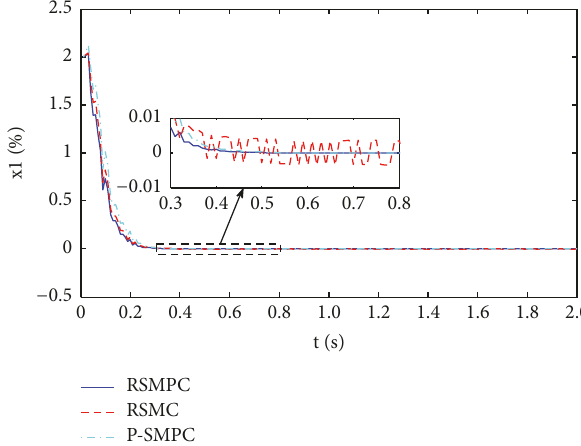
Figure 6: Response curves of system state 𝑥 1 under disturbance condition 1.